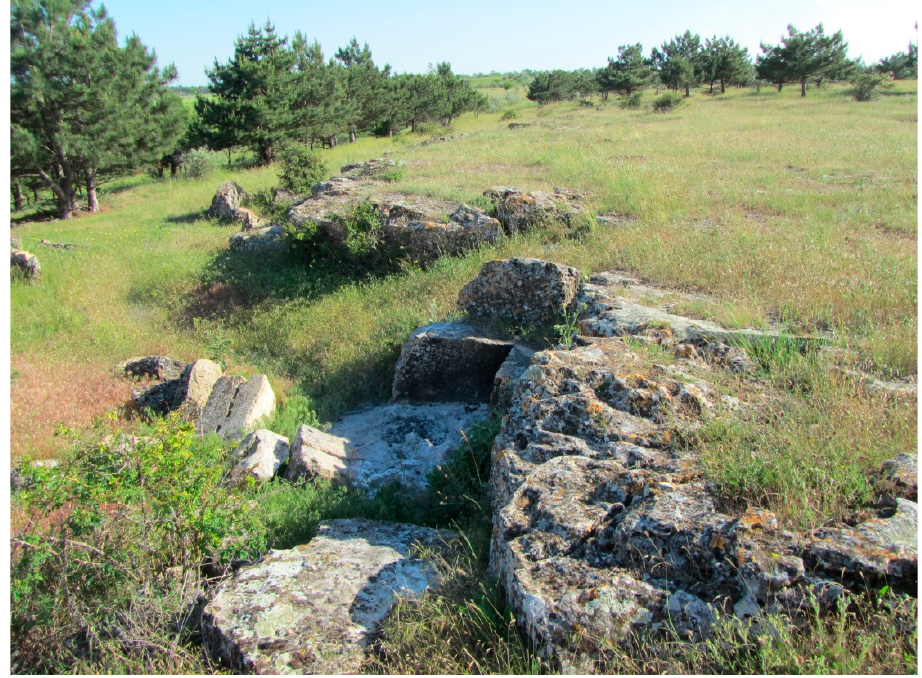
Figure 19. Plantations of Pinus pallasiana on artificial terraces (surroundings of Kovalivka village). Ulmus laevis and Elaeagnus angustifolia are naturally restored in gullies and depres- sions on the slopes, and E. angustifolia forms a strip of vegetation around the estuary. In their grass cover, demutation processes of natural steppe vegetation occur (Figure 20).